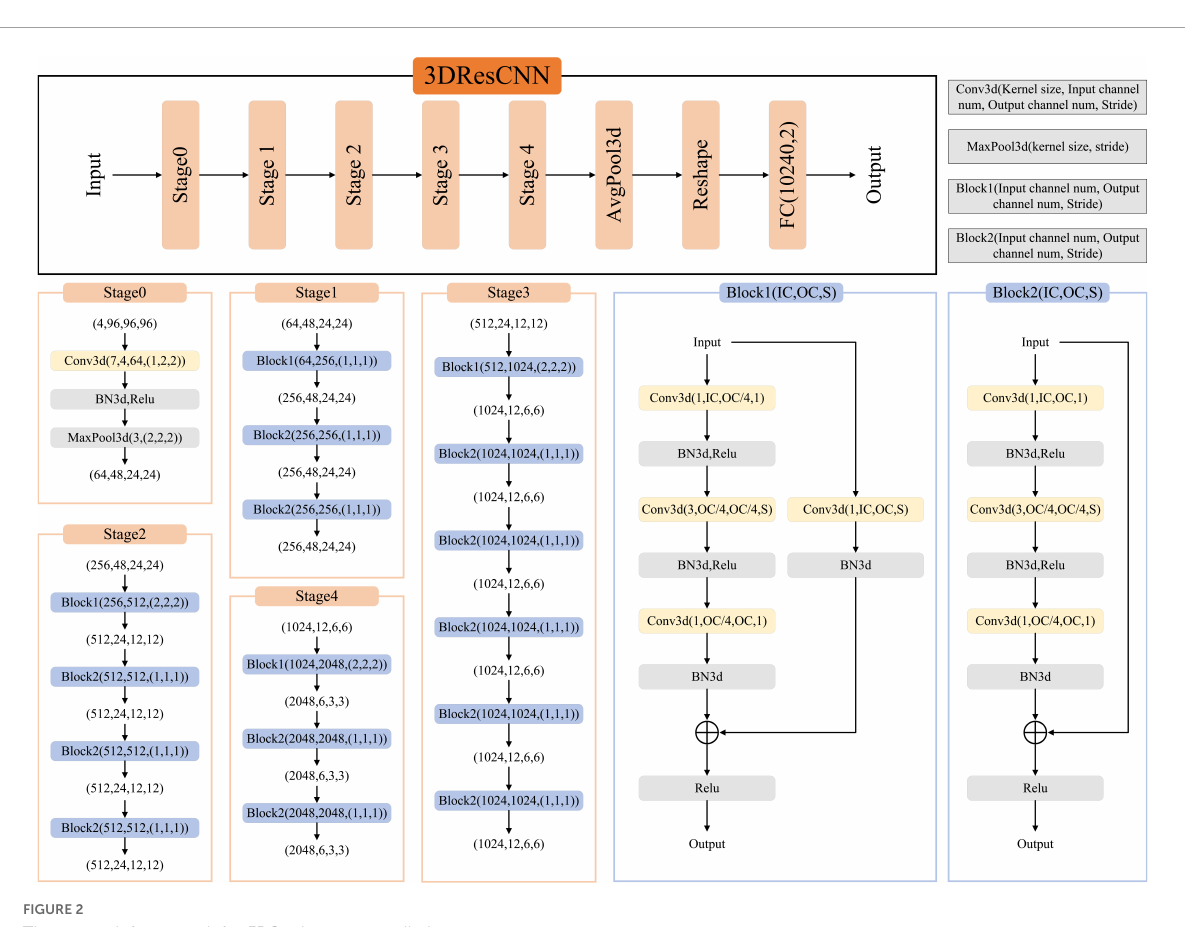
Figure 5 . The FRG-related risk score was calculated according to the LASSO weighting coefficients of the final selected